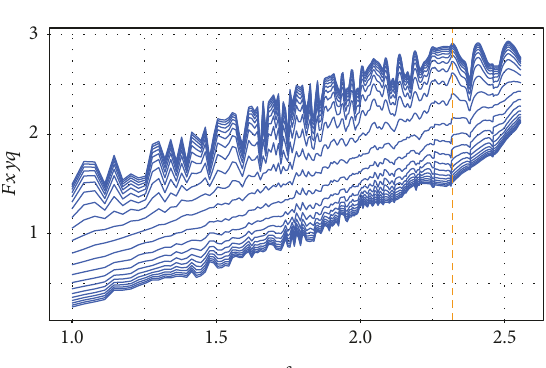
Figure 3: Log-log plots of 𝐹 𝑥𝑦𝑞 (𝑠) versus 𝑠 for amount of MM news and the amount of NM news.